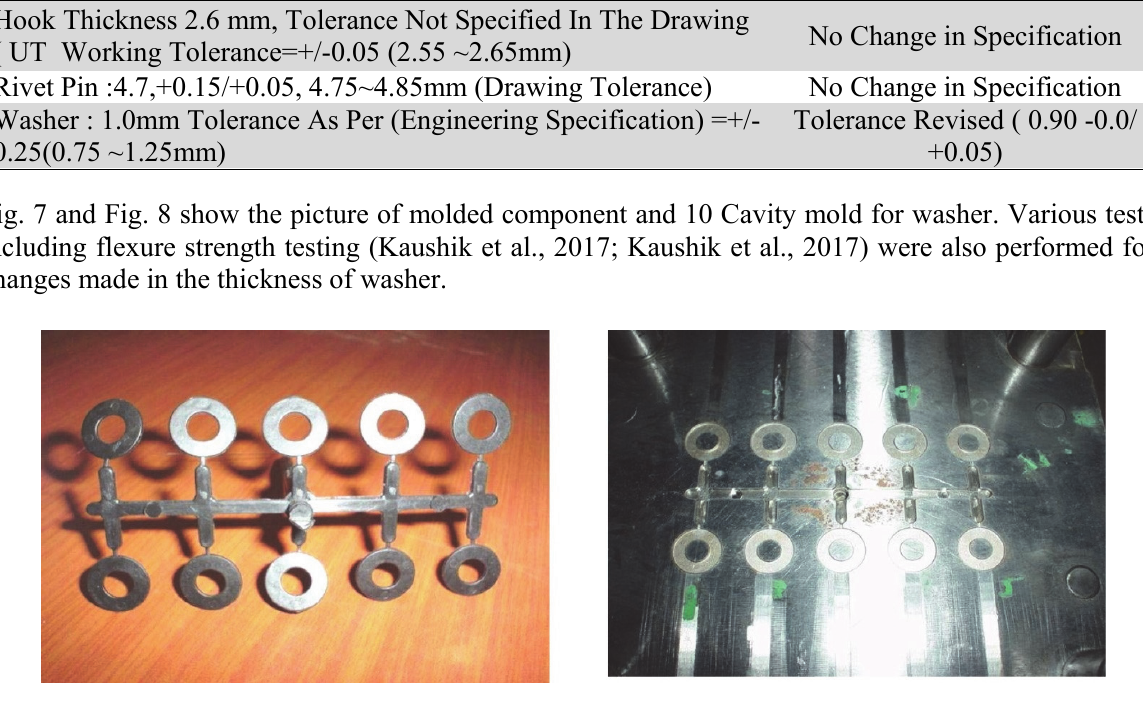
Corrective Actions for Revising Tolerance in Mold Design COMPONENT RESPONSE Hook Thickness 2.6 mm, Tolerance Not Specified In The Drawing ( UT Working Tolerance=+/-0.05 (2.55 ~2.65mm)